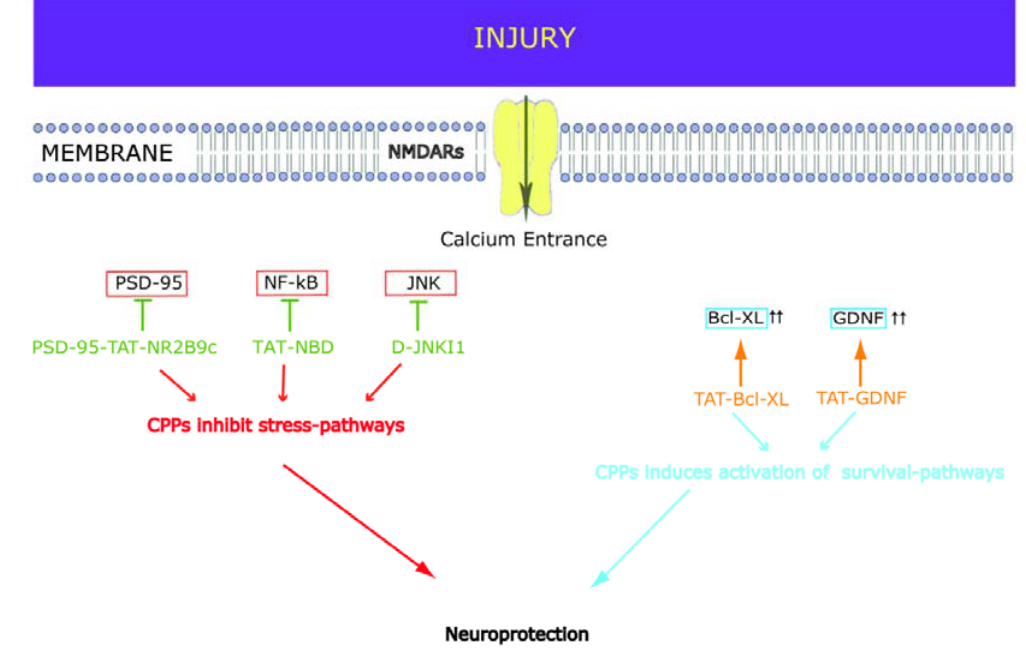
Figure 2. Schematic representation of the described neuroprotective CPPs and their protein targets. The stress pathways that are triggered by injury and the survival pathways that are activated in neuroprotective mechanisms are presented. We here indicate the two different families of CPPs: inhibitor ( ⊥ ) CPPs in red and stabiliser ( ⇑⇑ ) CPPs of protective proteins in orange. Inhibitor-CPPs: PSD-95-TAT-NR2B9c blocks the interaction between PSD-95 and the NMDA receptor subunit NR2B. D- JNKI1 blocks the association of JNK with its JBD-targets and inhibits JNK signaling pathways. TAT-NBD inhibits NF-kB activity by blocking association of its key regulators: NEMO (NF-kB essential modulator) with the IKKs (I Kappa B kinases). Stabiliser-CPPs: TAT-Bcl-xL induces Bcl-xL overexpression and subsequently prevents caspase activation. TAT-GDNF induces GDNF stabilization and inhibits caspase